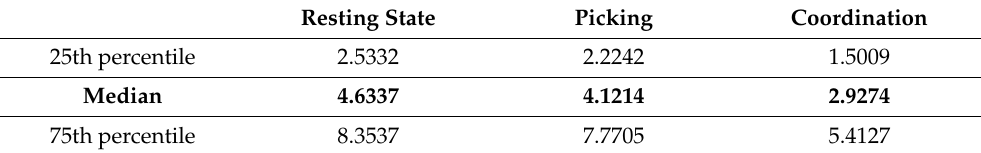
Table 1. Theta-Beta Ratio (TBR) distribution by the experimental state—main percentile values. Resting State Picking Coordination 25th percentile